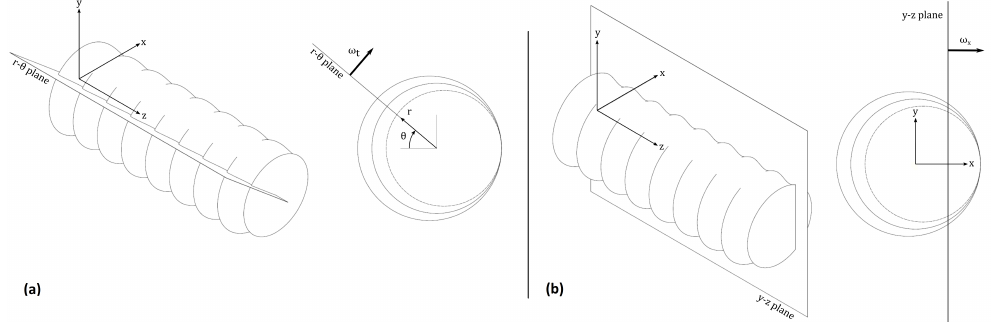
Figure 14. Planes and coordinates chosen to best follow the evolution of vorticity along the surface and after separation: tangent component ω t for the cylinders’ frontal part ( a ) and streamwise component ω x for the cylinders’ rear part ( b